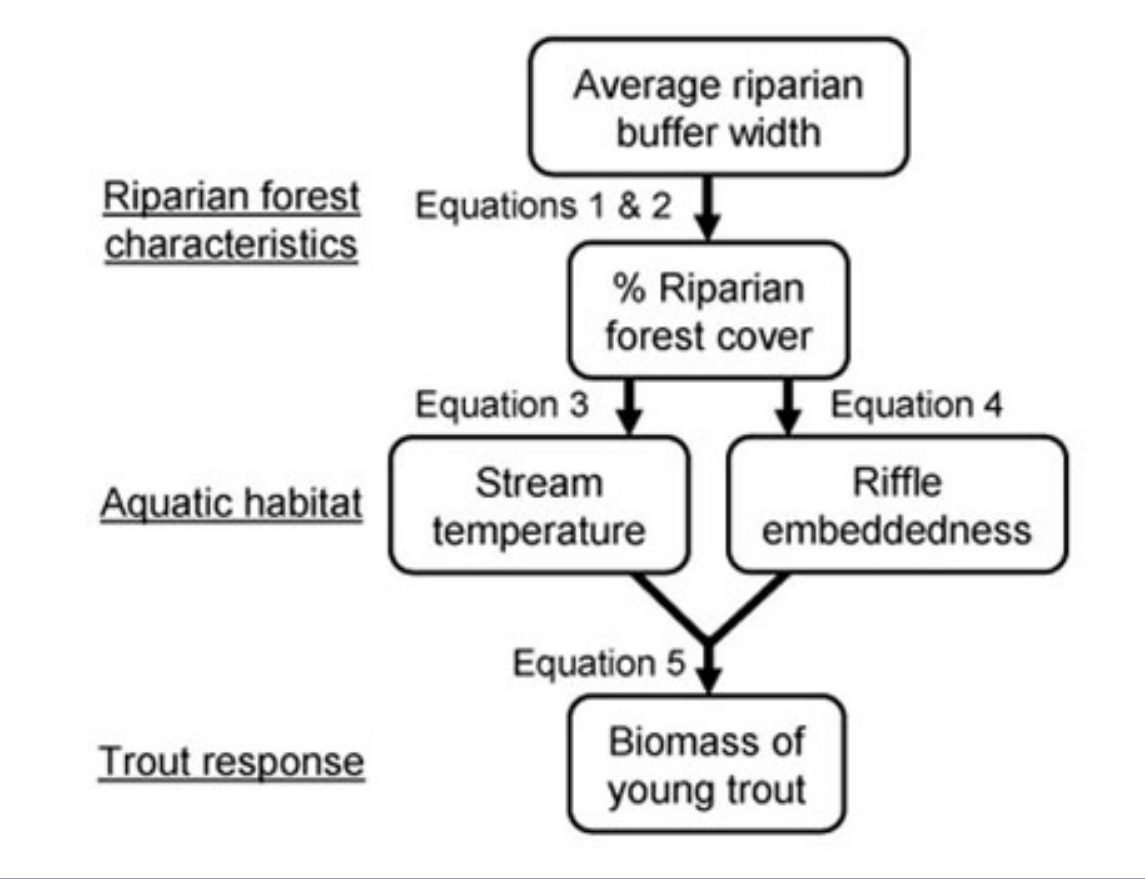
Fig. 1. Conceptual framework for quantifying the relationships between forested riparian buffers, aquatic habitat, and trout populations in north Georgia. Riparian buffers directly influence stream temperature and riffle embeddedness (or fine sediment accumulation in riffle habitats) and, thereby, indirectly influence trout